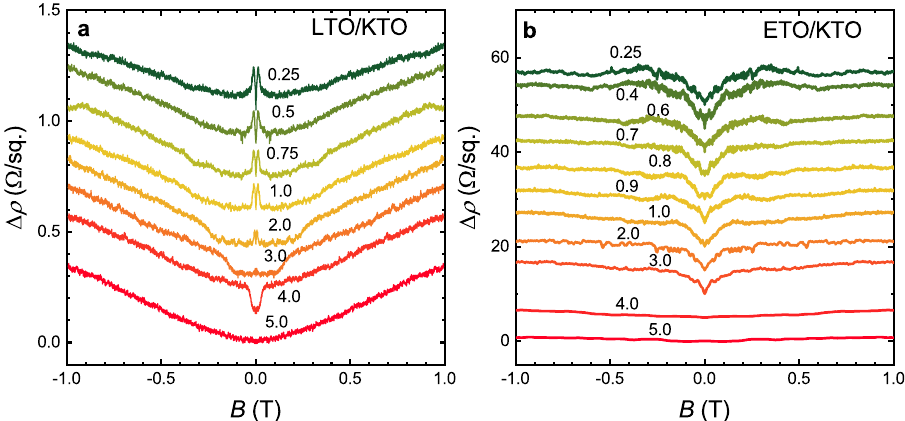
Fig. 2 Magnetoresistivity (MR) of LTO/KTO and ETO/KTO. MR is given by Δ ρ ¼ ρ B ð Þ (cid:2) ρ ð 0 Þ for LTO/KTO plotted in ( a ) and ETO/KTO plotted in ( b ). Curves are vertically shifted for clarity, and temperatures for each MR curve are